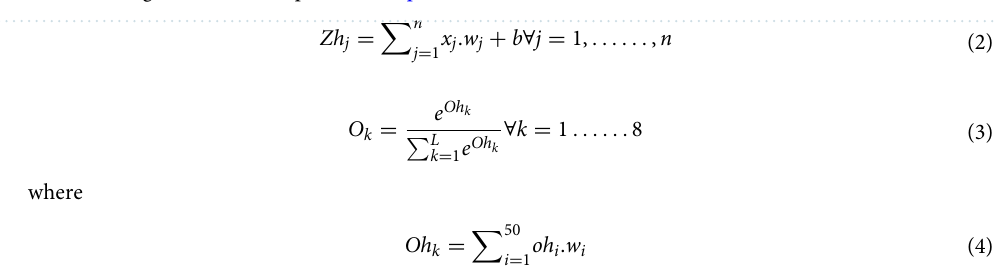
Figure 4. Sample for the Essential oils dataset imported by Azure. The Picture is taken from the Azure machine learning studio (classic) platform, https ://studi o.azure